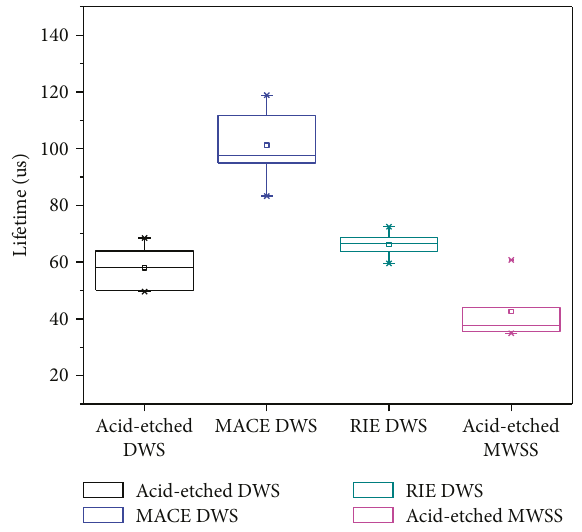
Figure 4: Minority carrier lifetime of wafers with di ff erent surface